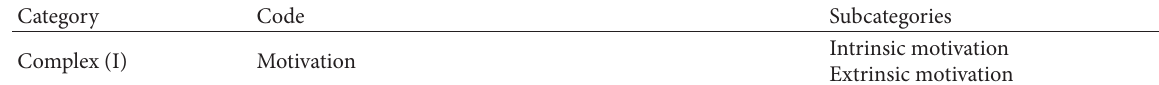
Table 3: Categories and subcategories for qualitative analyses.